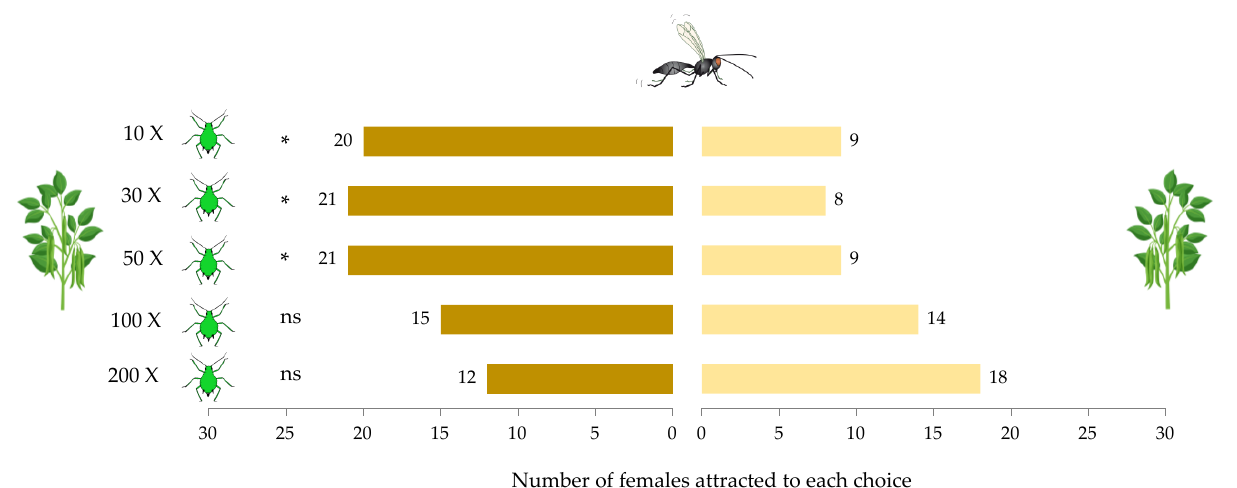
Figure 1. Response of Aphidius ervi females toward non-infested vs. aphid-infested plants with various aphid densities (10, 30, 50, 100, and 200 individuals of Acyrthosiphon pisum ). (*) represents significant interaction between aphid density and type of infestation. Table 1. The time taken (Median with IQR) in seconds by Aphidius ervi females to make a decision between aphid-infested and non-infested plants. No significant differences were found. Time Taken in Seconds by Parasitoid Females to Make a Decision Individual Density Aphid-Infested Plants Non-Infested Plants